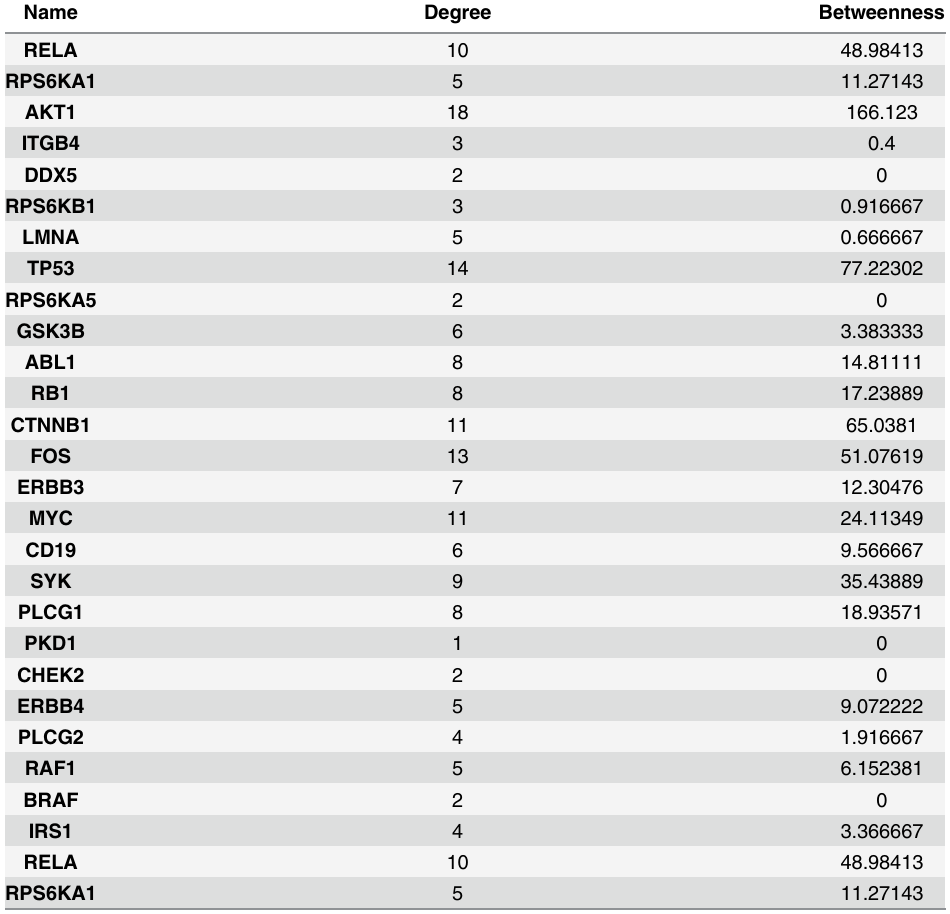
Table 6. Significantly enriched modular of up-regulated proteins using CentiScaPe software.